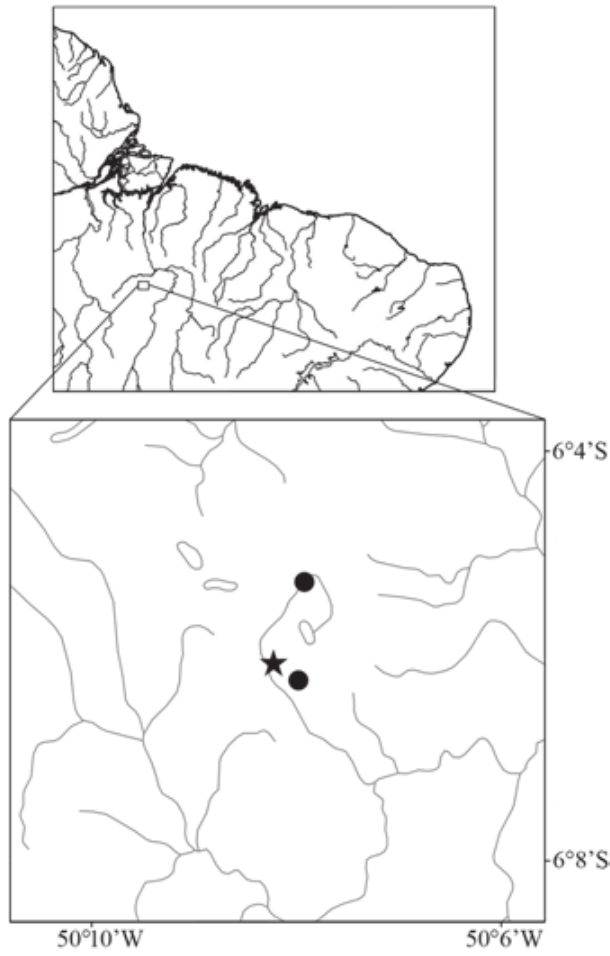
Fig. 4. Map of part of the northern and northeastern South America showing the distribution of Ituglanis ina . Star represents the type